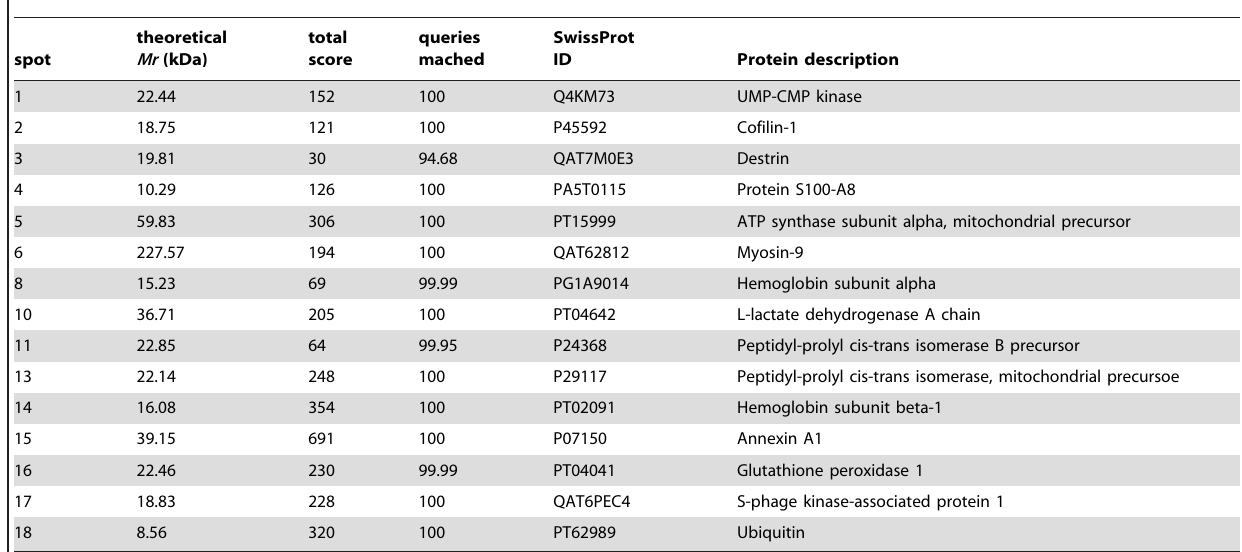
Table 1. List of Identified Protein Spots Differentially Expressed in control, LPS, and LPS plus propofol groups.